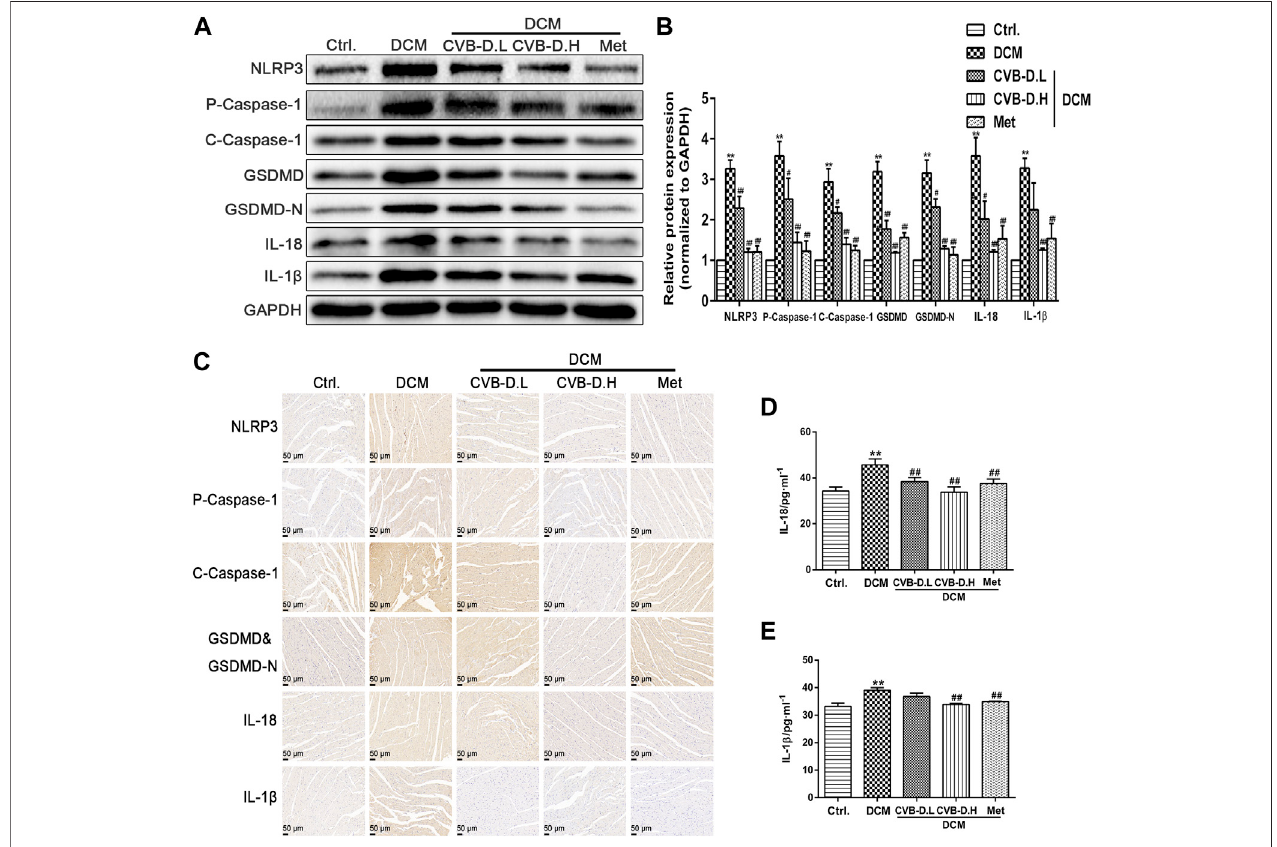
FIGURE4| CVB-Dinhibitestheexpressionofpyroptosis-relatedproteinsinthehearttissueofDCMmice. (A,B) DeterminationofNLRP3andpyroptosispathway- related proteins expression in heart tissues of DCM mice by western blotting, and all proteins expression were normalized to GAPDH. (C) The expressions of NLRP3, P-Caspase-1 (Pro-Caspase-1), C-Caspase-1 (Cleaved-Caspase-1), GSDMD&GSDMD-N, IL-18 and IL-1 β were observed by immunohistochemistry. (D,E) Effects of CVB-D on the contents of IL-18 and IL-1 β in mice serum. The data are presented as the mean ± SEM ( n = 6), * p < 0.05, ** p < 0.01 versus the control group; # p < 0.05, ## p < 0.01 versus the model